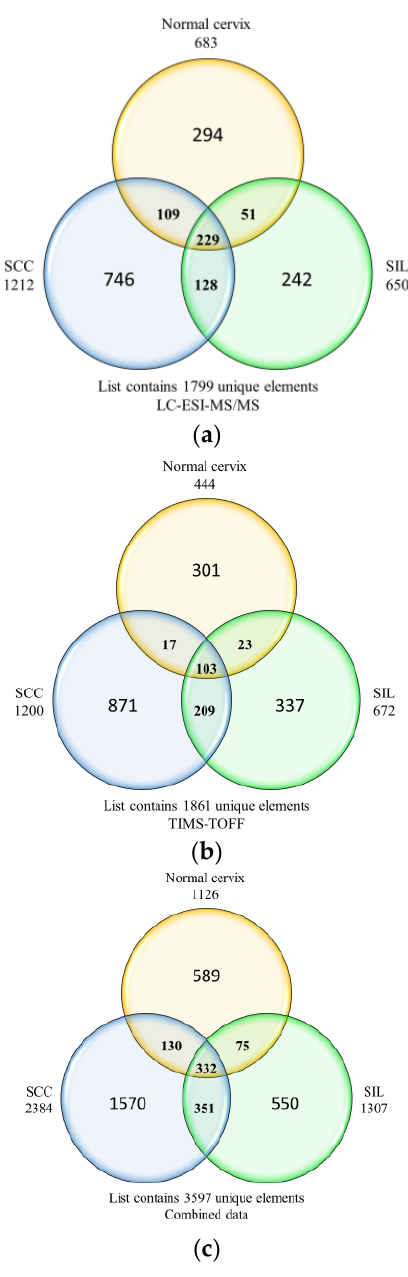
Figure 1. Venn diagram depicting the unique and overlapping proteins in the normal cervix, SIL, and SCC groups from ( a ) LC-ESI-MS/MS ( b ) timsTOF MS and ( c ) combined data. The protein is considered signi fi cant when − 10logP is ≥ 20 and the unique peptide is ≥ 1.